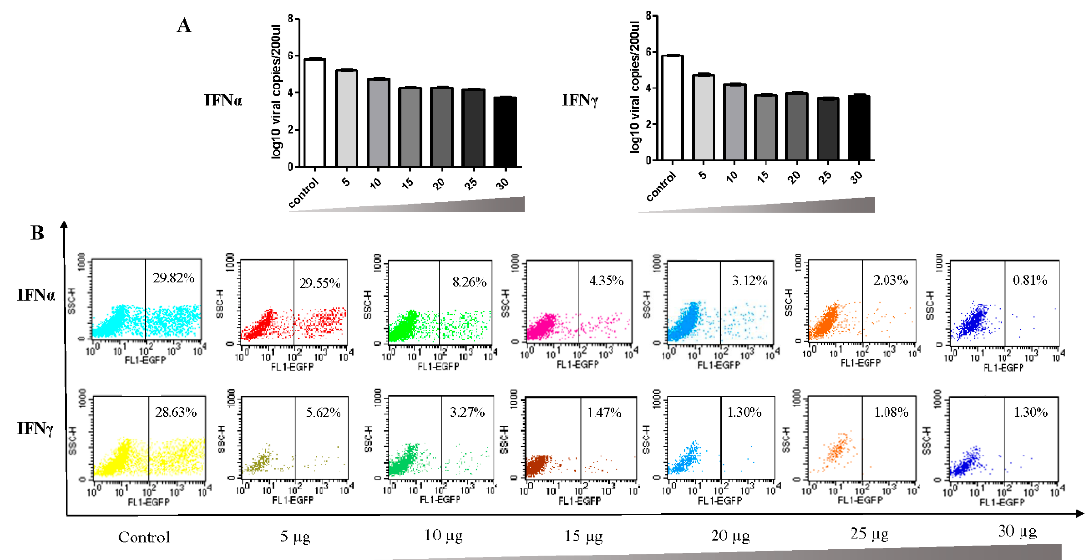
Figure 5. Dose-dependent inhibition of DPV replication by IFN α and IFN γ as examined by viral copy number detection ( A ) and flow cytometry analysis ( B ). Effects of different concentrations of IFN α and IFN γ on DPV DNA copy numbers. DPV UL30 DNA copies in DEF cells of control groups and experimental groups were detected by RT-qPCR at 36 hpi after protein pretreatment as above. The number of UL30 DNA copies was assessed in triplicate wells. Flow cytometry analysis of DPV-EGFP positive cells with different concentrations of IFN were also analyzed by flow cytometry. The percentage of EGFP-positive cells automatically calculated by the CellQuest software. Flow cytometry was used to analyze cells with GFP fluorescence. Plots of the data indicate the percentage of cells expressing GFP (right quadrant) above the background level of fluorescence associated with the uninfected control cells.